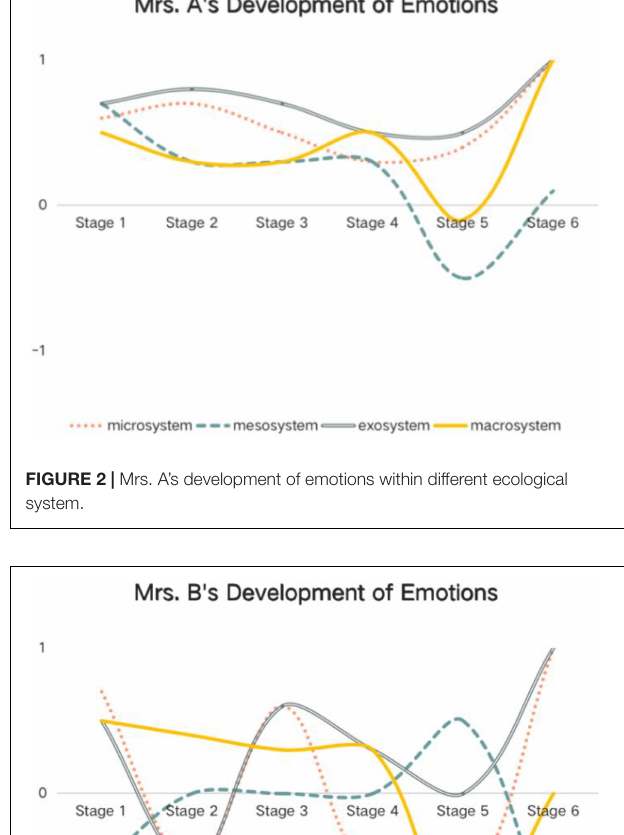
Mrs. B’s emotions fluctuated widely. Her positive